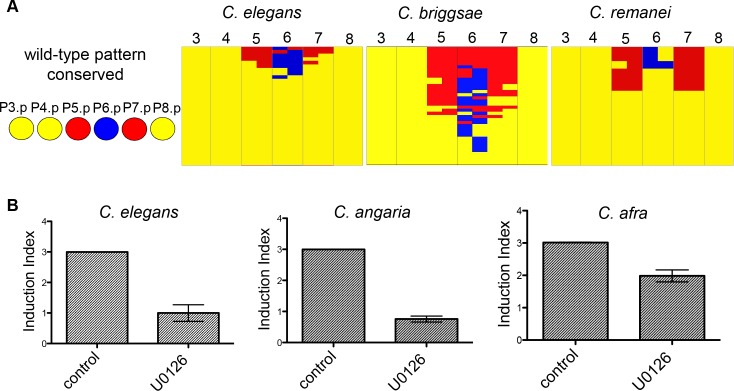
lin-3 activity in vulval induction is conserved in Caenorhabditis species.(A) Comparative lin-3 RNAi effect on vulva induction in C. elegans, C. briggsae and C. remanei. Tables show graphically the observed defects in vulval cell fate pattern after scoring at least 100 nematodes. Every column is a distinct Pn.p cell (3 to 8) and 1° fate is depicted in blue, 2° fate is depicted in red and 3° fate in yellow. Half fates represent cases where the Pn.p daughter cells adopt different cell fates after the first cell division. The defects are ordered based on their consequence on vulval induction index, from high index to low. (B) Treatment with the MEK inhibitor U0126 decreases vulval induction in C. elegans (n = 15 for DMSO control and 10 μM U0126 treatment), C. angaria (n = 32 for control, n = 27 for 150 μM U0126 treatment) and C. afra (n = 100 for control, n = 30 for 150 μM treatment), as measured by the vulval induction index (average number of induced Pn.p cells at the population, wild-type index = 3). In all cases P<0.0001 with a Mann Whitney test.